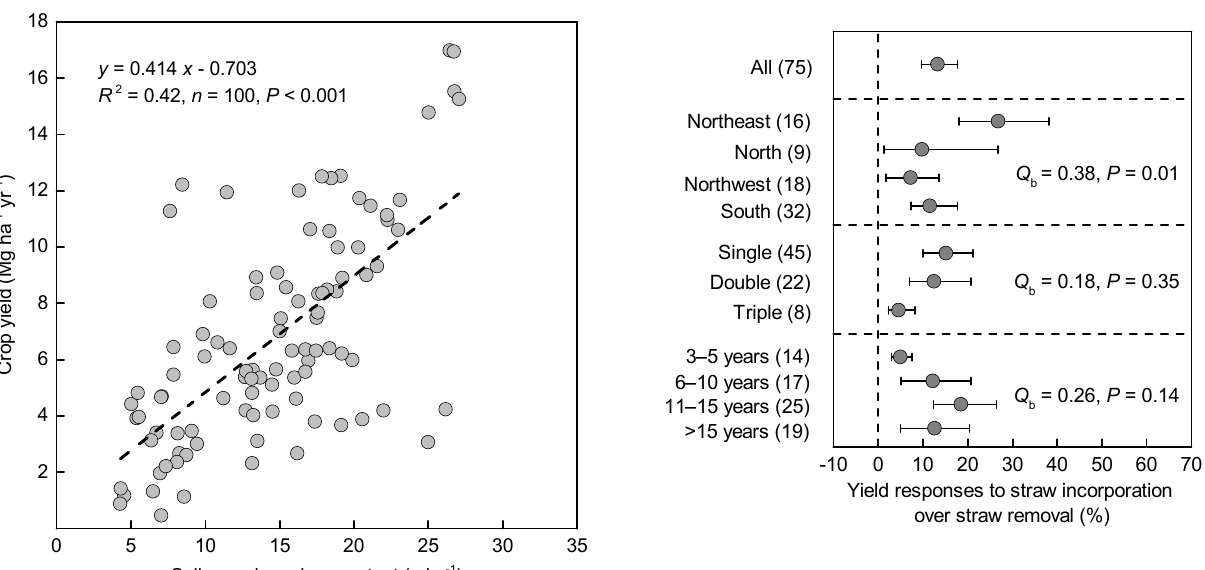
Figure 3. Responses of crop yield to SI compared with SR (a) , cate- gorized into (b) region, (c) crop frequency and (d) experiment dura- tion. Yield responses are expressed as the relative increase (%) com- pared with control (SR) with 95% CIs represented by the error bars. Numbers of paired observations are in parentheses. Between-group heterogeneity ( Q b ) and the probability ( P ) were used to describe statistical differences in yield responses between different levels of the categorized